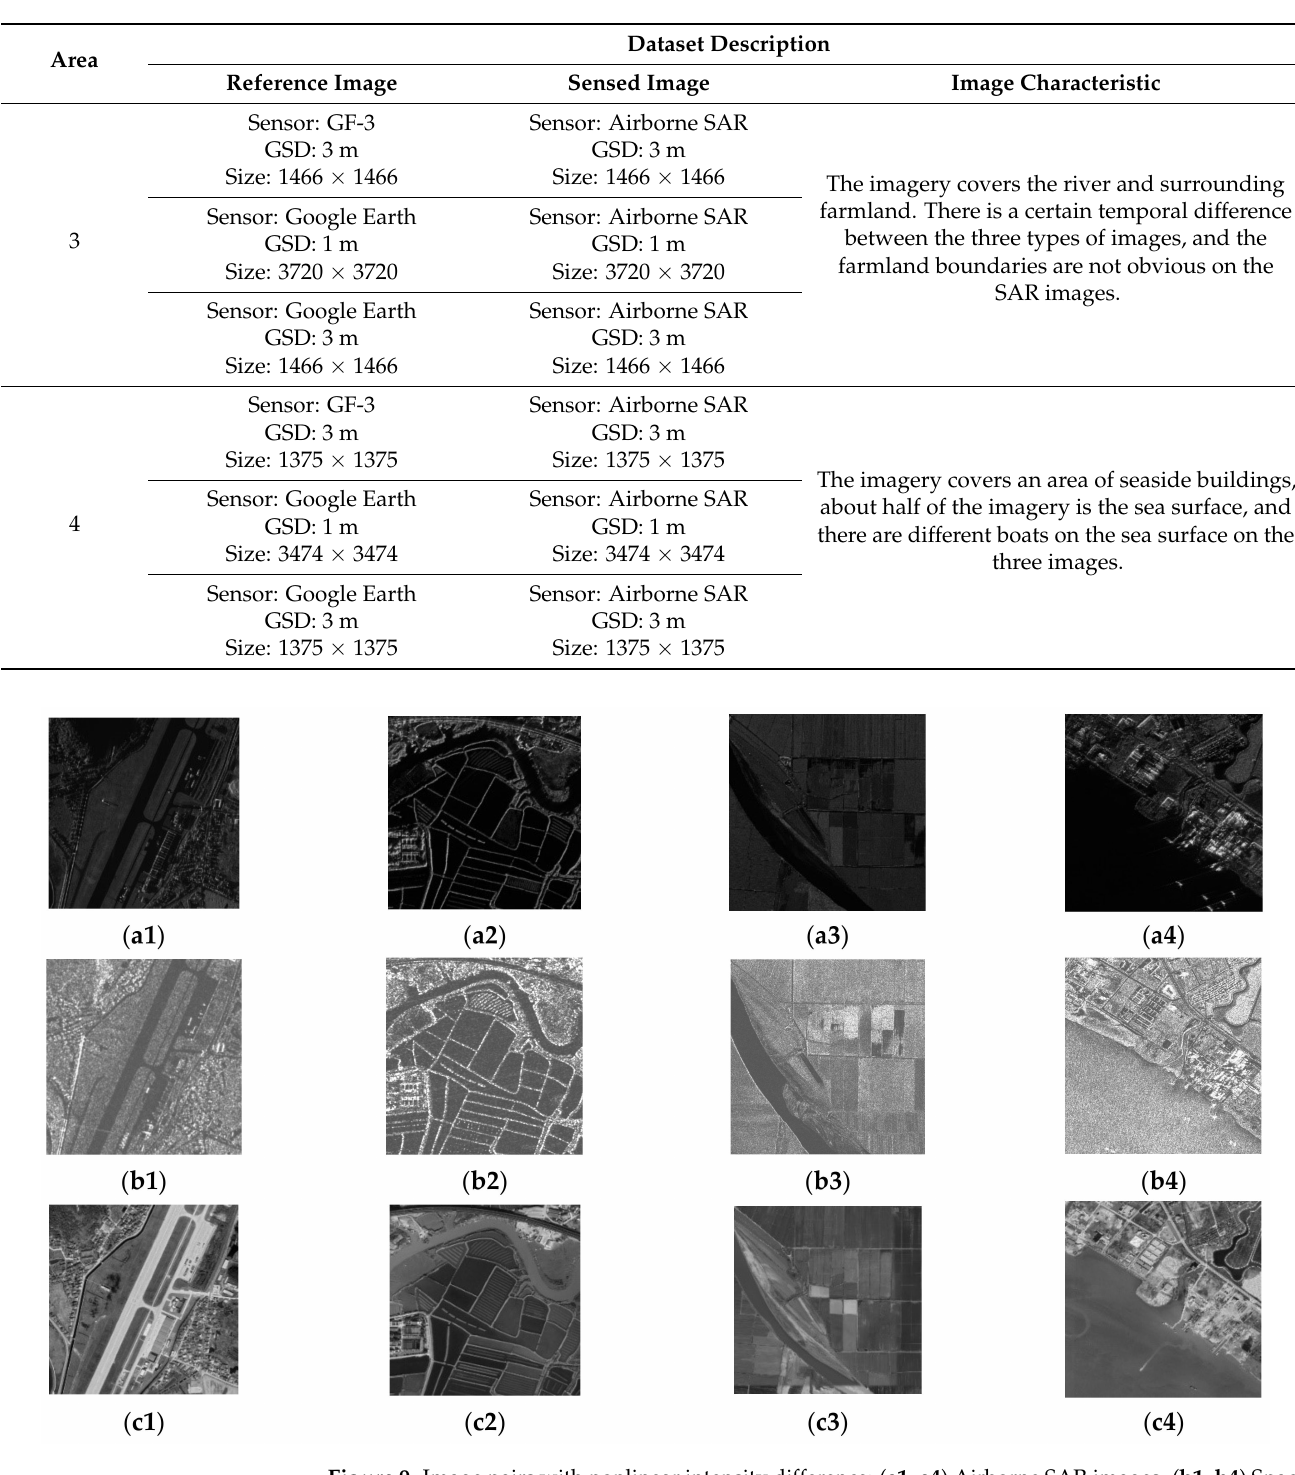
Figure 9. Image pairs with nonlinear intensity difference: ( a1 – a4 ) Airborne SAR images. ( b1 – b4 ) Space- borne SAR images. ( c1 – c4 ) Optical